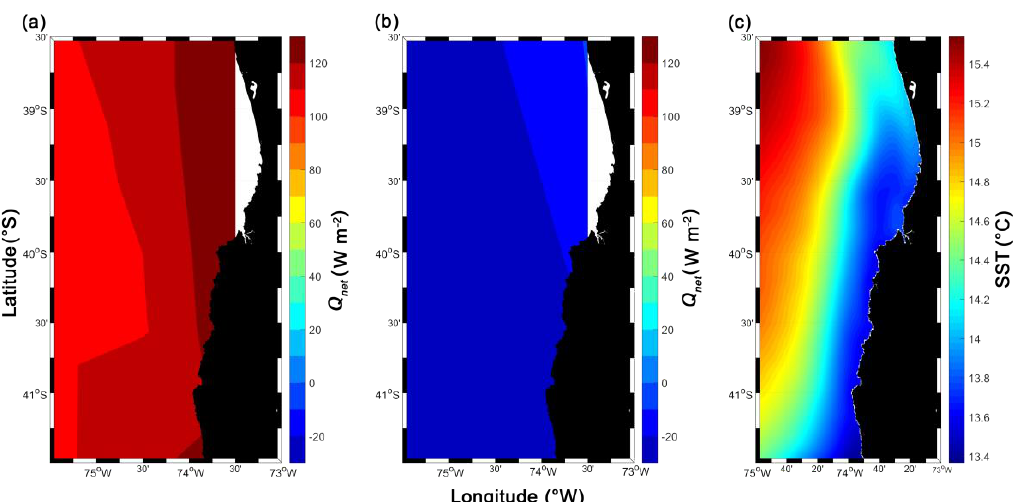
Figure 2. Long-term averages of net surface heat flux ( Q net , W m − 2 ) for ( a ) austral spring – summer and ( b ) autumn – winter, and ( c ) SST (°C) for spring – summer seasons. Q net was obtained from WHOI Objectively Analyzed Air – Sea Fluxes [24] and their long-term averages correspond to values during 1984 – 2009.